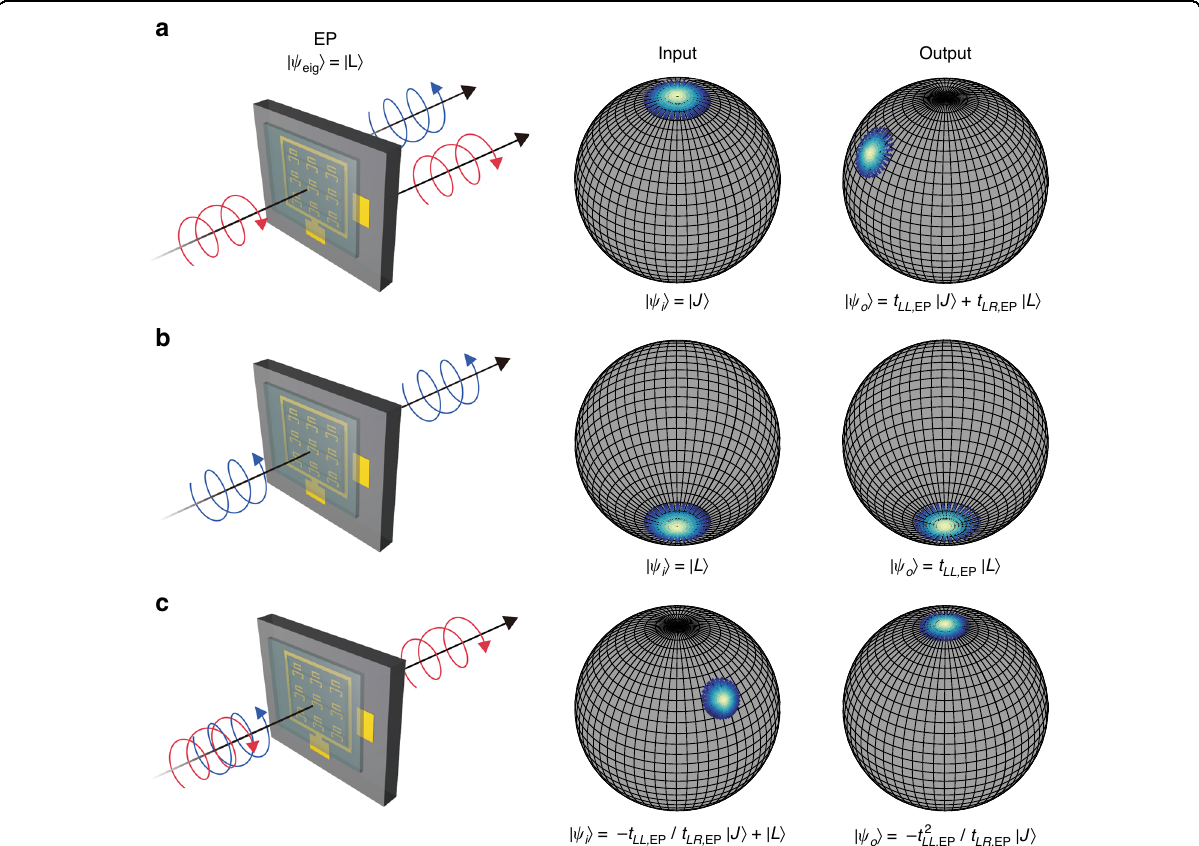
Fig. 4 Peculiar linkage between input and output states at the chiral EP. a - c Conceptual schemes (left) and the calculated results from the measured Jones matrix for input states (middle), and output states (right) on the Poincare ́ sphere for three polarisation input states at the chiral EP. a For the input state with RCP, the output polarisation states are superposed with RCP and LCP. b Only the LCP component is transmitted for the input state with LCP. c For speci fi c input states where the LCP components destructively interfere with each other, the RCP component is only transmitted, and then the missing dimension is